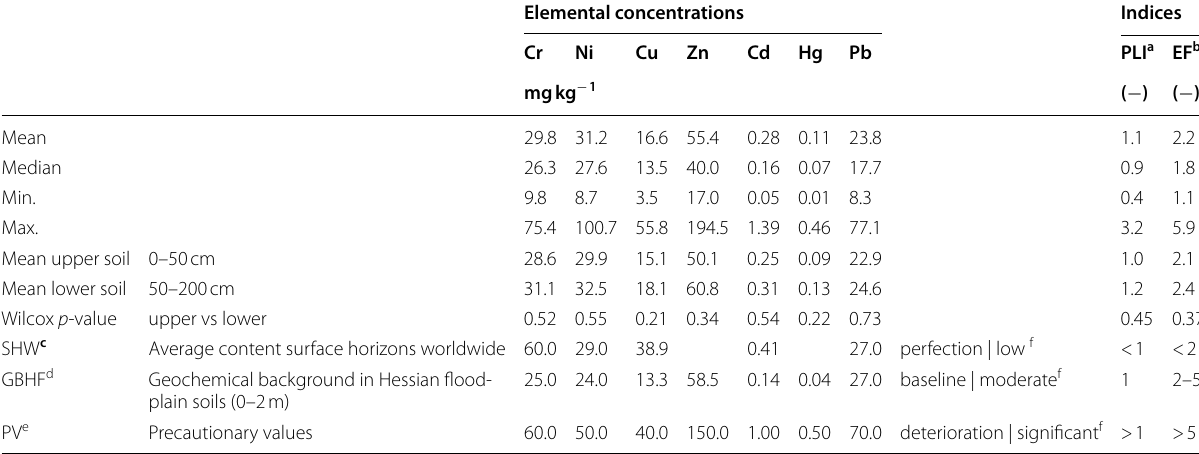
Table 2 Summary of trace metal contents compared to geogenic background levels and legislation values with calculated pollution indices and their